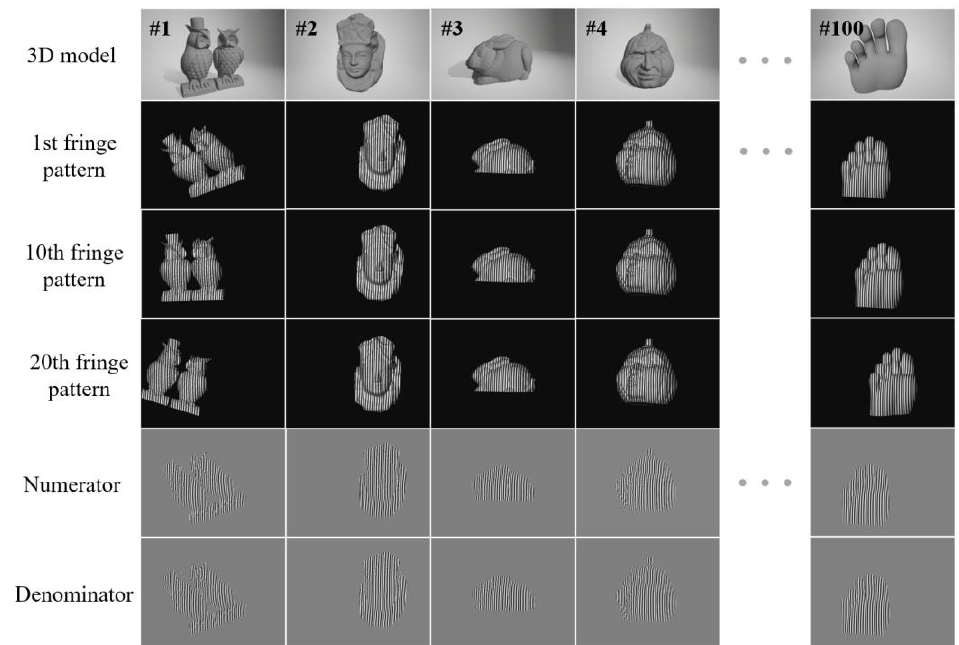
Figure 3. Collection of the training data and validation data. The first row shows the different 3D models used in the virtual FPP system. Each 3D model with different motion type was measured by 24 frames fringe patterns of the three-step PSP, in which the 1st, 10th, and 20th images are shown in the second to fourth row. The ground truth numerator and denominator of the first frame are shown in the fifth and sixth row.